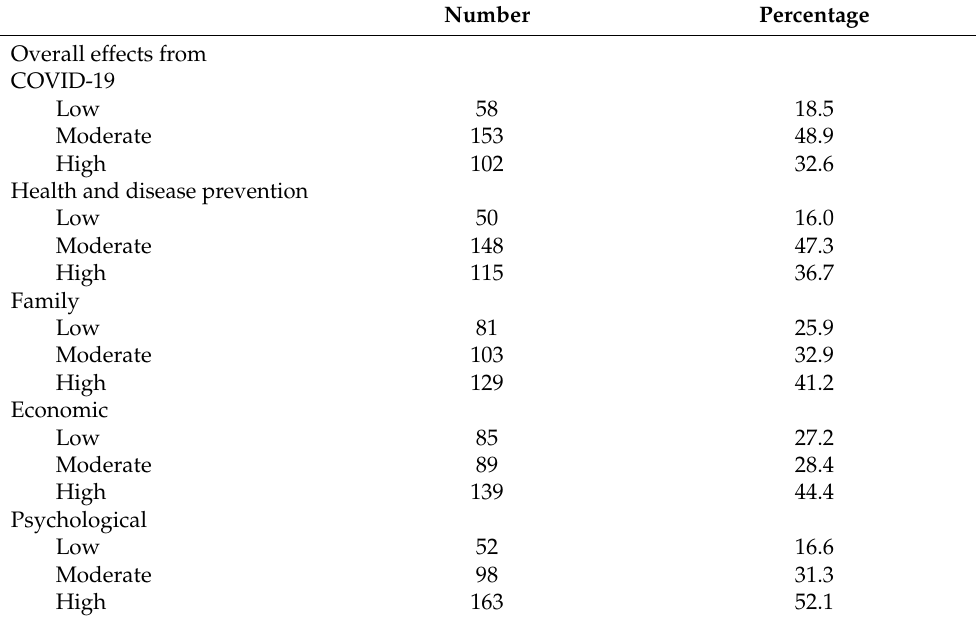
Table 2. Characteristics of effects from COVID-19.